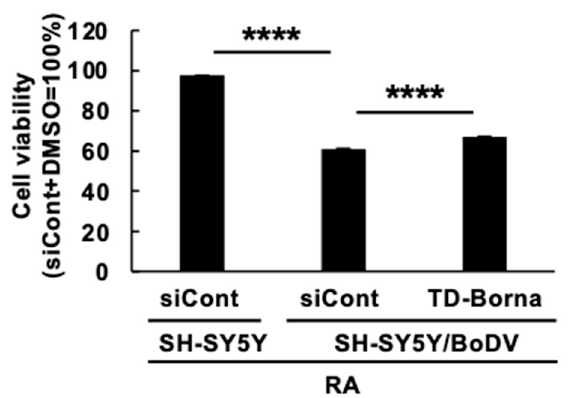
Figure 5. Effect of TD-Borna treatment on cell viability during differentiation of SH-SY5Y/BoDV cells. SH-SY5Y or SH-SY5Y/BoDV cells were treated with RA in the presence of the scrambled siRNA (siCont) or TD-Borna for 2 days. The cell viability was evaluated by using a CellTiter Glo Luminescent Cell Viability Assay. Values are expressed as the mean percentage + SEM of three independent experiments. ****, p <